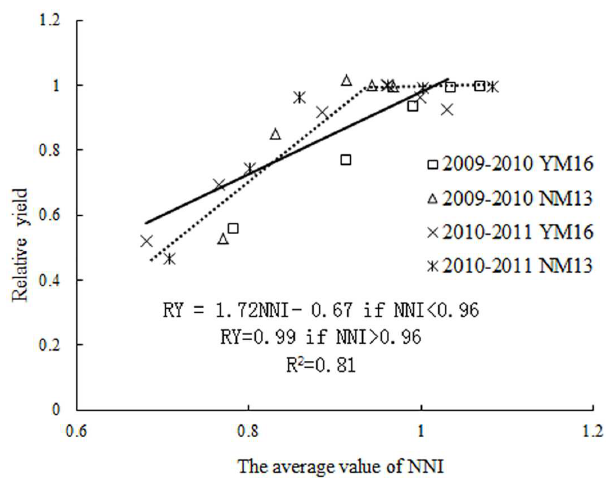
Fig 7. The relationship between RY and NNI for winter wheat in 2009–2011. The NNI value was averaged over all